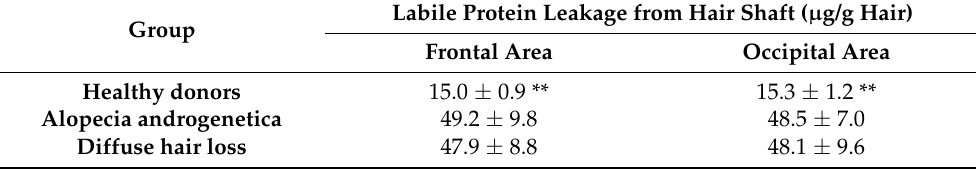
Table 5. Labile protein leakage ( µ g/g hair) from hair shafts taken from the frontal and occipital areas of healthy donors and patients with different types of